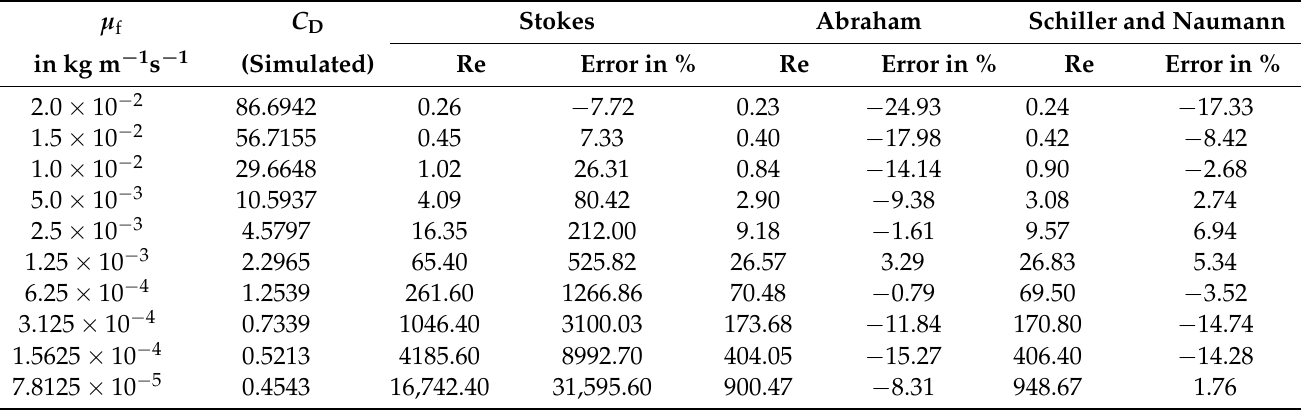
Table 6. Deviation of of the drag coefficients calculated by homogenized lattice Boltzmann method (HLBM) simulations to different drag